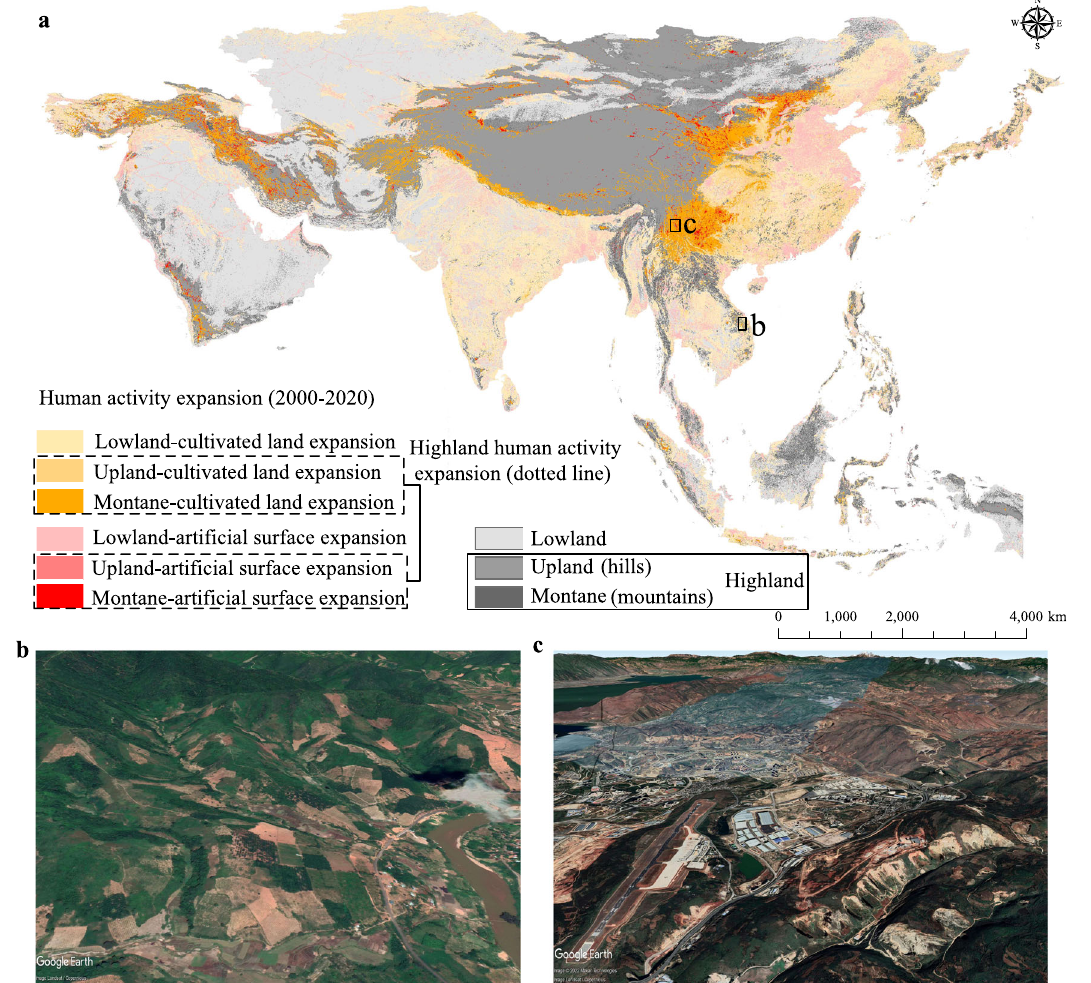
Fig. 1 | Spatial distribution of human activity expansions in Asia from 2000 to 2020. a Map of human activity expansion areas according to landforms and land use information (30m resolution), b cultivated land expansion in the highlands